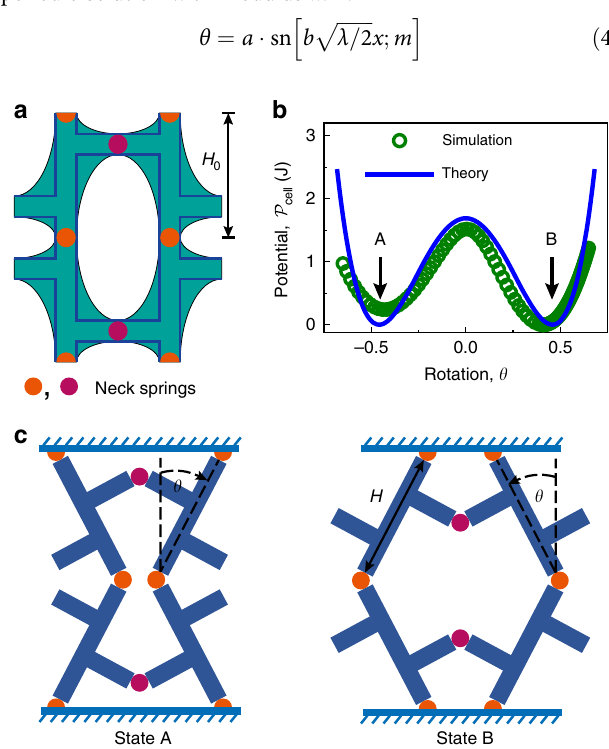
Fig. 2 Bi-stability of the unit cell under compression. a Schematic of the unit cell and the corresponding theoretical model. The simpli fi ed theoretical model consisting of elastic rods and neck springs (yellow and magenta dots) is illustratively superimposed on the unit cell of the sample. b The on- δ ; θ ð Þ of the unit cell under vertical compression strain site potential P cell ε ¼ 10 : 7 % . c Two possible buckling con fi gurations (polarization states) of the unit cell corresponding to the two equilibrium states of the double-well potential shown in b .